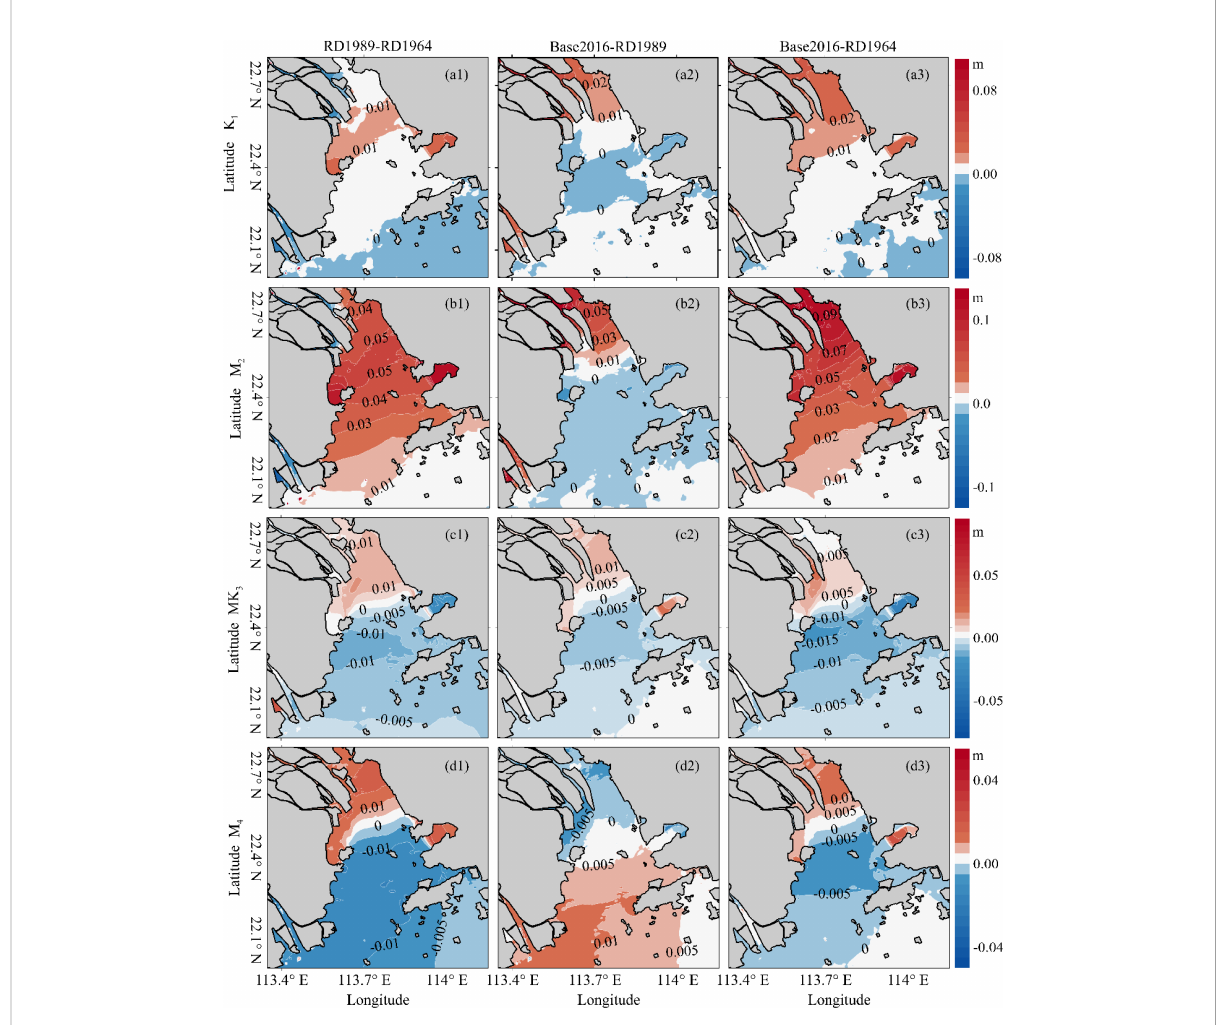
0.1 m. The M 4 tide is a shallow water constituent derived from the semidiurnal M 2 tides. Although its amplitude is relatively small, interactions between the M 4 and M 2 tides are one of the main sources contributing to tidal asymmetry. In the fi rst period (Figure 5D1), the M 4 tidal amplitude increased at the top of the estuary bay and in the river networks, whereas it decreased in the middle and lower parts of the bay. This variation pattern of the amplitude change was reversed in the second period (Figure 5D2), where the M 4 tidal amplitudes increased in the outer LDB and decreased in the inner LDB. For 1964-2016 (Figure 5D3), the cumulative change in the M 4 tidal amplitude shows that the increasing area is located at the top of the bay, and the decreasing area is located in the middle and lower parts of the